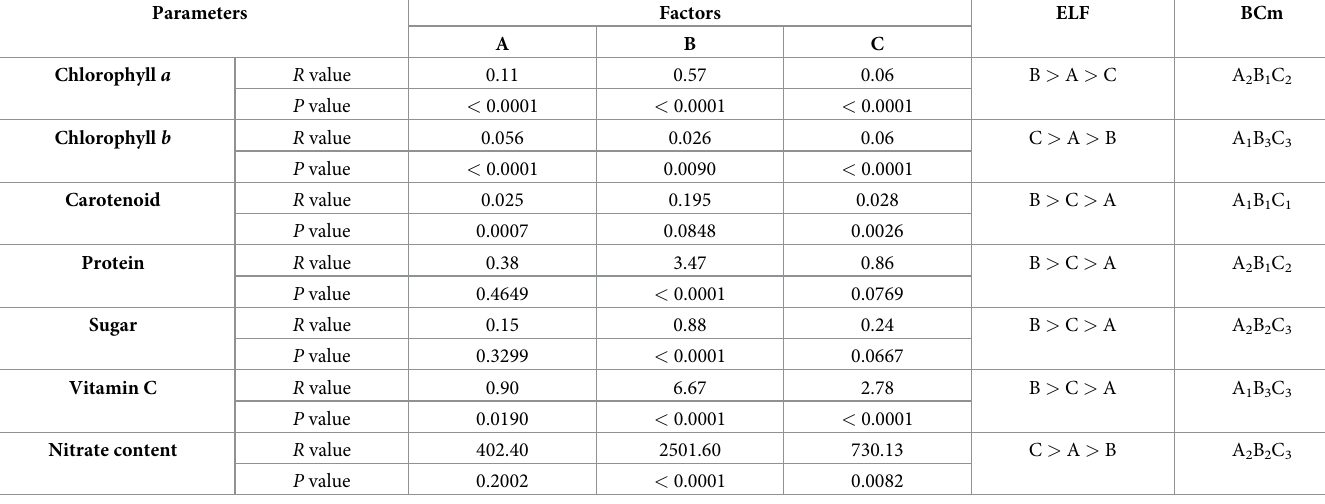
Table 3. Results of the range and ANOVA of the L9 (3 3 ) matrix for the influence of combined intensities of LEDs light (A), light spectral ratios (B), and photoperiod (C) on chlorophyll and biochemical contents of rocket plants.